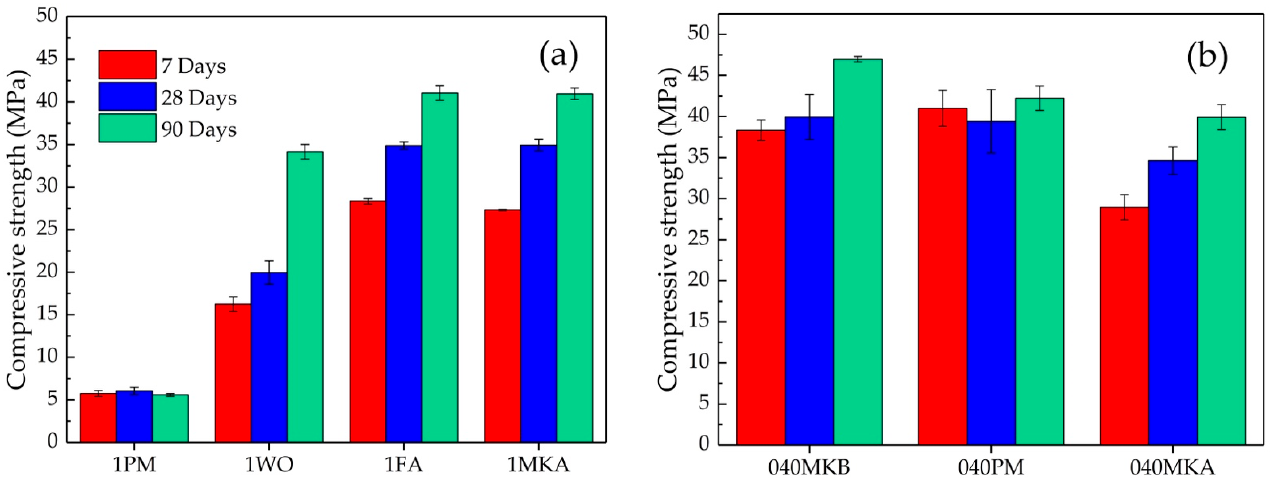
Figure 2. Compressive strength of MKPC mortars. ( a ) Mortars with a fixed filler/cement mass ratio of 1.00; ( b ) mortars with a fixed water/cement mass ratio of 0.51. of 1.00; ( b ) mortars with a fixed water/cement mass ratio of